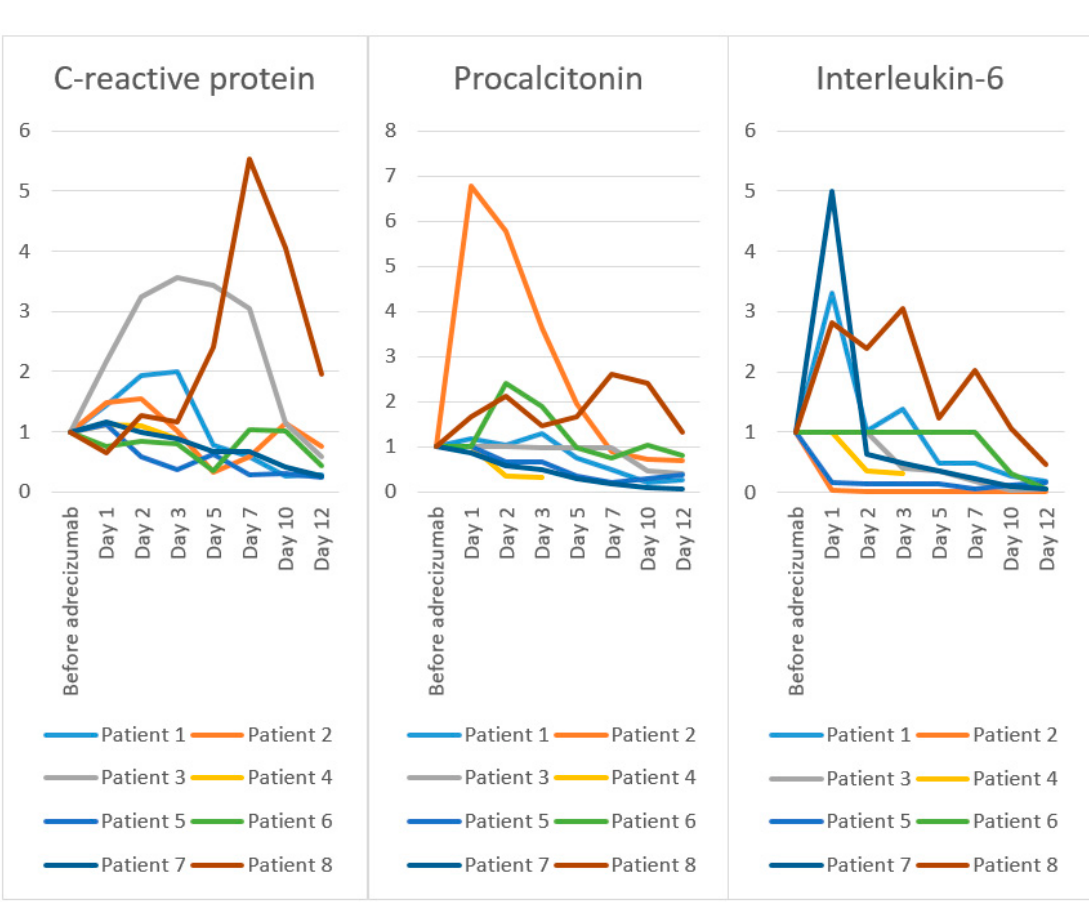
Figure 2. Change in inflammatory parameters (baseline levels normalized to 1) during follow-up.